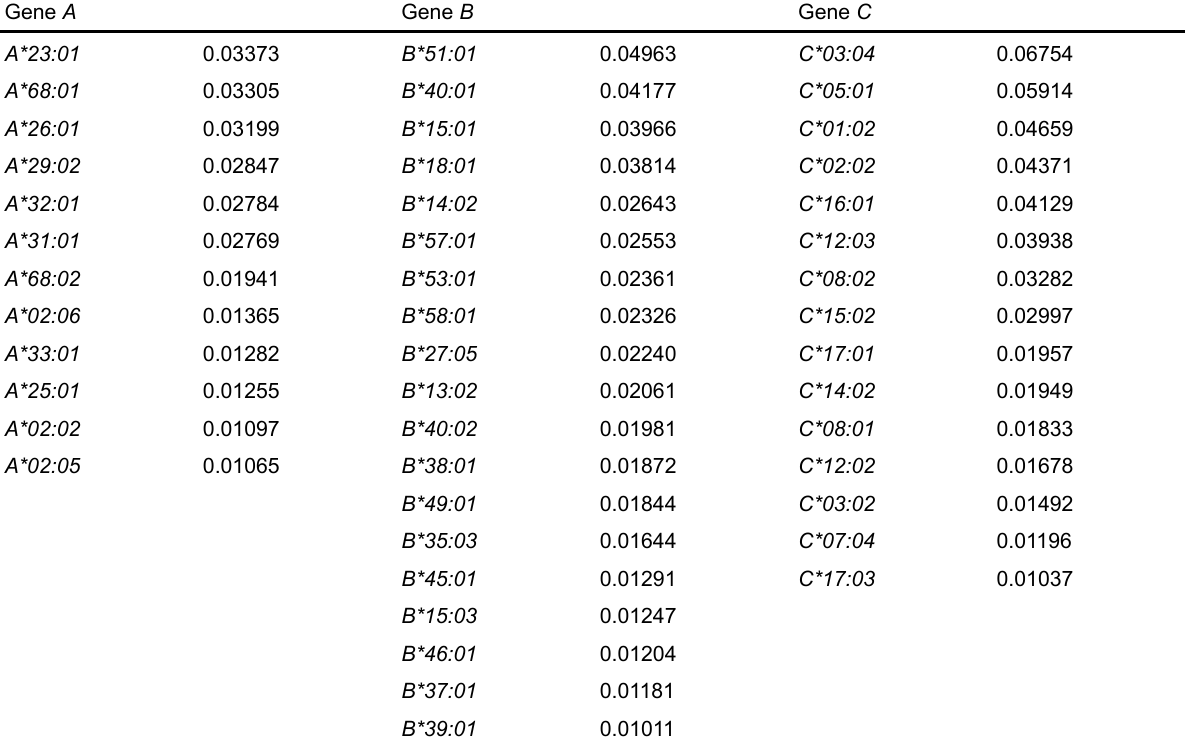
Table 1. HLA class I alleles used, ordered by their global frequencies in descending order (see text for details, continued ) Gene A Gene B Gene